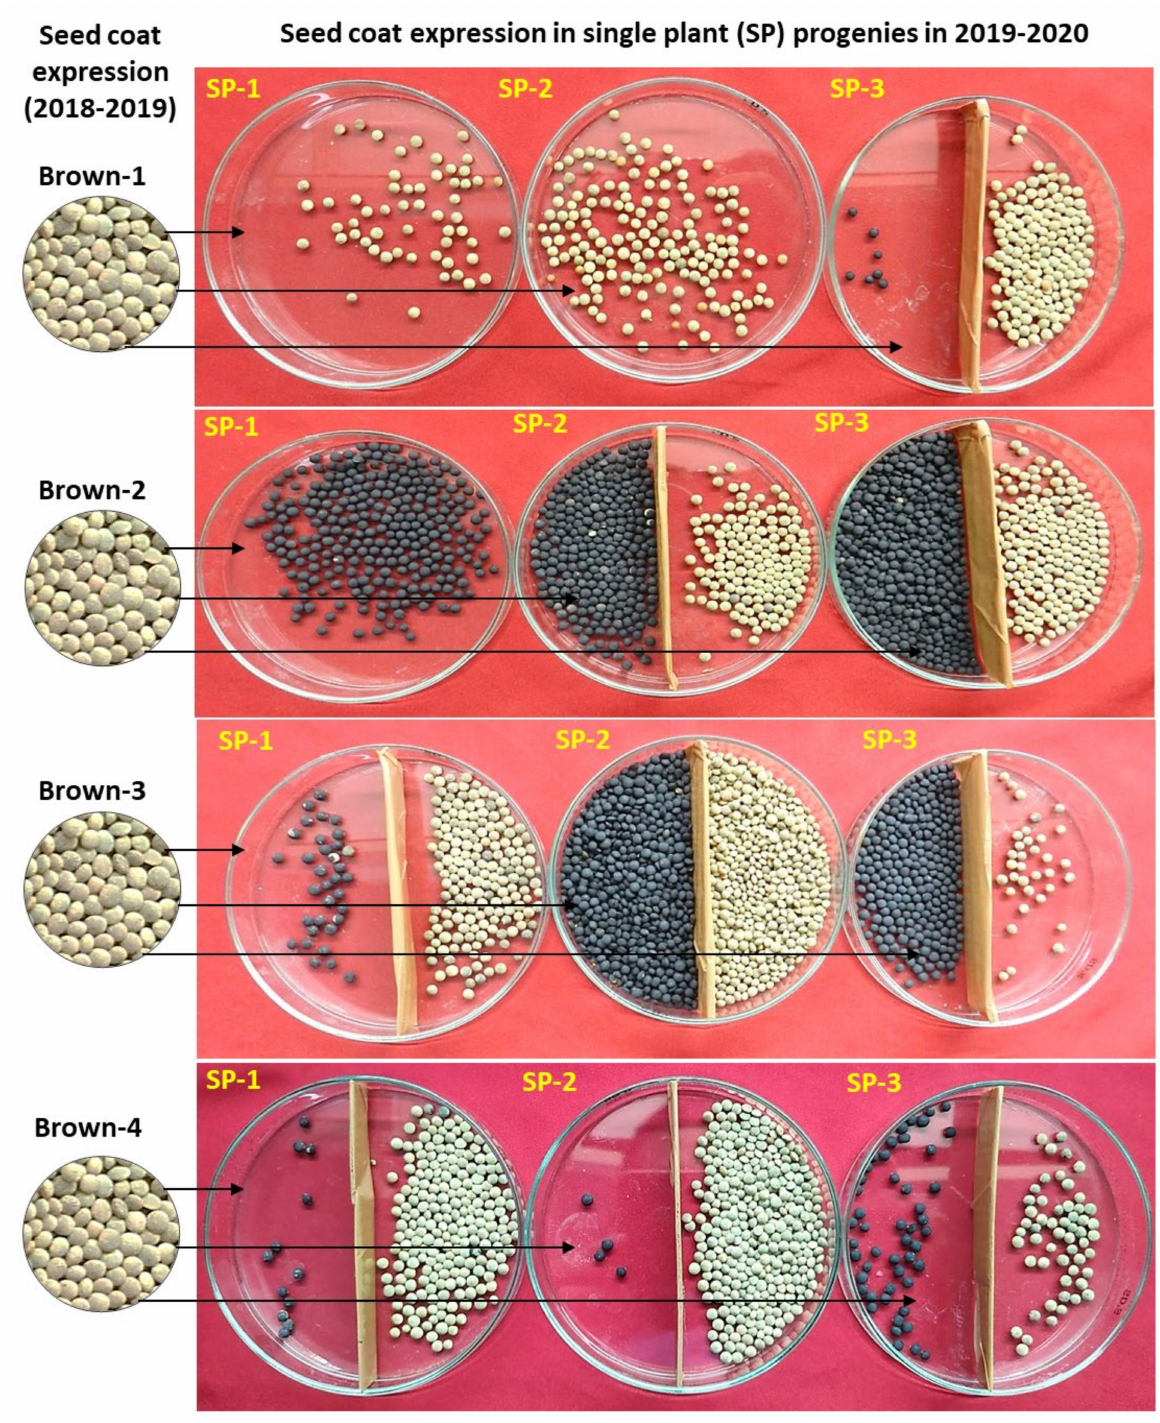
Figure 2. Seed-coat expression of three single plants (SP-1 to SP-3) in the year 2019–2020 derived from the four plants seeds (L4717-NM) having brown seed-coat expression (Brown-1 to Brown-4) in the year 2018–2019. Black/spotted and brown seed-coat colored seeds (if formed) were separated in a Petri plate (obtained from a single plant) for more clarity of their relative frequencies per